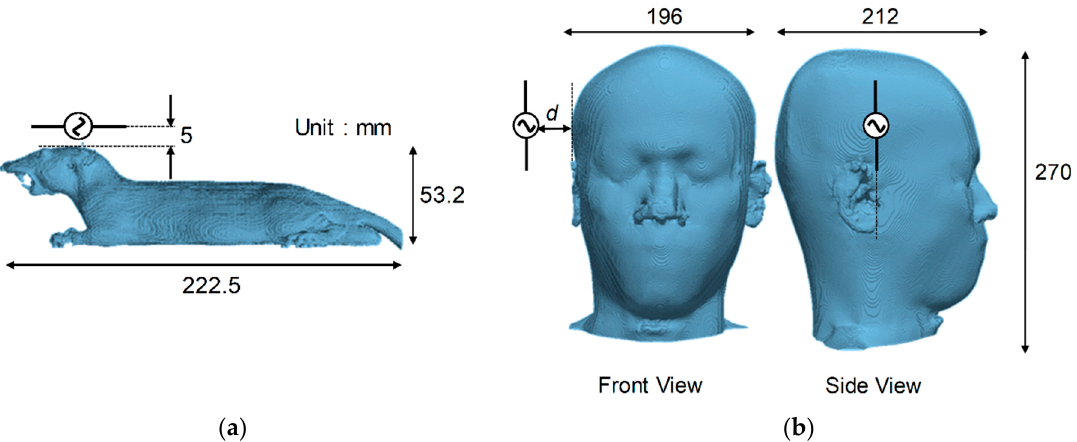
Figure 1. Exposure scenarios for computational ( a ) rat and ( b ) human head models (TARO). The separations between the antenna and the rat and human models are 5 mm and 5–25 mm, respectively.